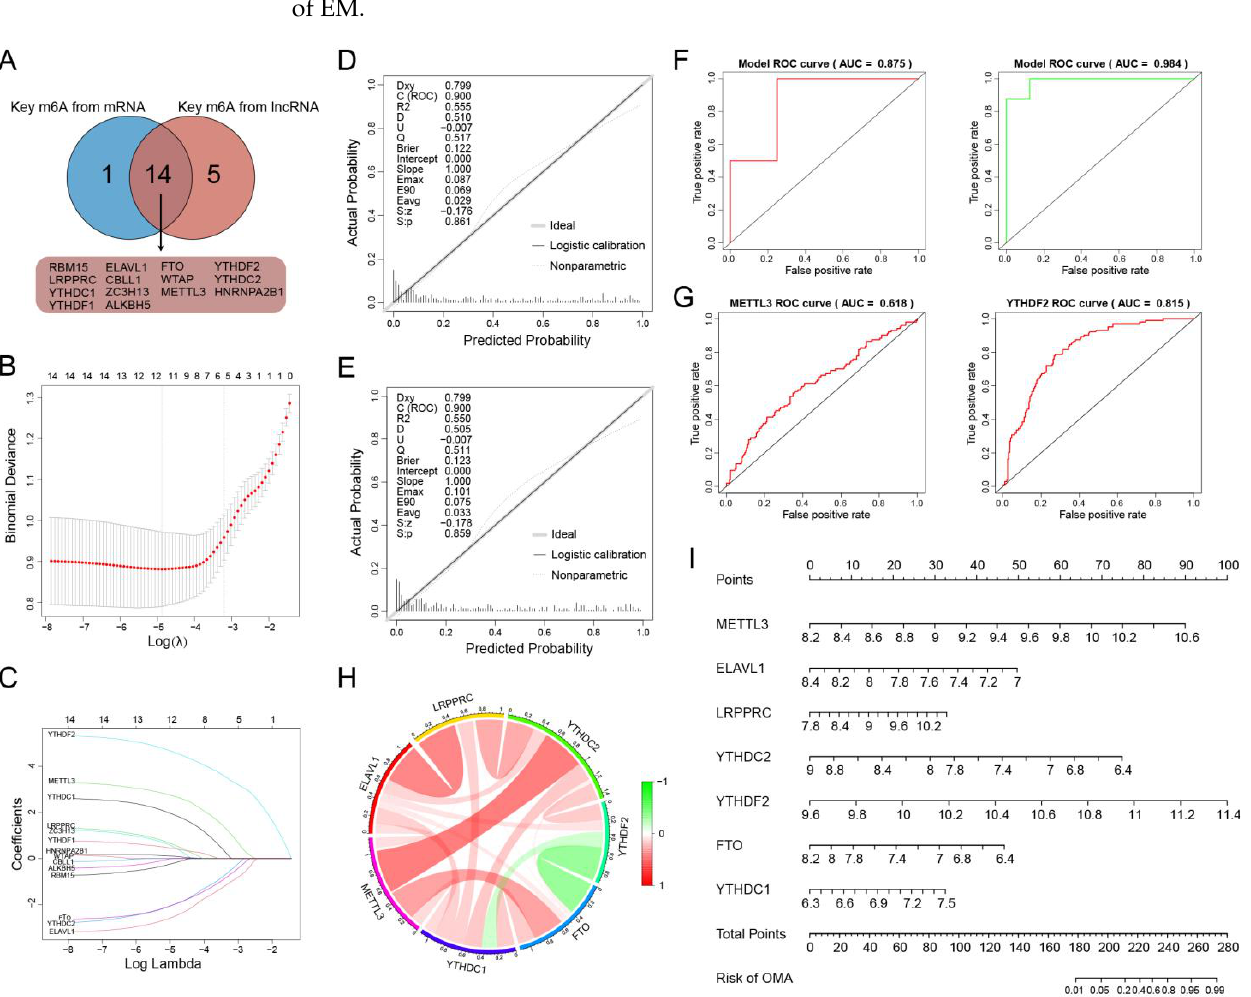
Figure 6. Establishment and validation of m6A diagnostic model. ( A ) The key m6A regulators overlapping in two networks were extracted for model training. 10-fold cross-validation for shrinking parameters ( B ) and extracting non-zero coefficients ( C ). ( D ) A diagnostic model was constructed by 14 m6As for EMs. ( E ) A concise model was further constructed by 7 m6As with AUC remaining high. ( F ) The roc plots for validation of the diagnostic model using GSE86534 and GSE105764. ( G ) The roc plots for METTL3 and YTHDF2, with the most prognostic potentialities among writers and readers, respectively. ( H ) The mutual relationship among the composition of the diagnostic model in circos plot in ectopic samples. ( I ) The nomogram for risk assessment in EMs. ROC, receiver operating characteristic; AUC, area under curve.